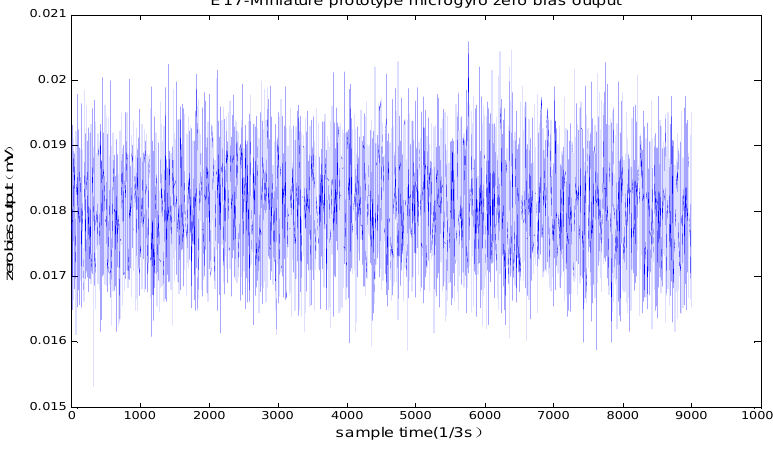
Figure 13. Zero bias stability testing.